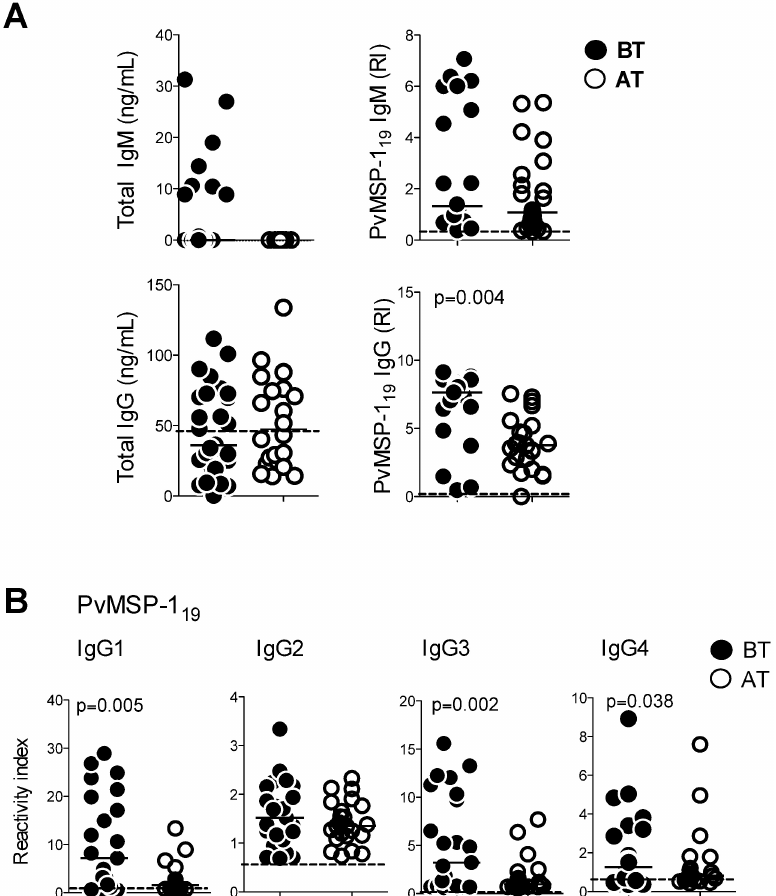
Fig 4. Increasein the reactivity index of IgM and IgG against MSP-1 19 from Plasmodium vivax during malaria. A. Total and Plasmodiumvivax -specific antibodieswere measuredby enzyme-linked immunosorbent assay (ELISA). Total and PvMSP-1 19 IgM and IgG were measuredin plasma of patients duringacute malaria (BT) and after treatment (AT). B. IgG subclasses againstPvMSP-1 19 were measure in plasma of patients duringacute malaria(BT) and after treatment (AT). Lines represent medianvalues of the given measurement in each group. Dotted lines represent healthydonors. p values are depictedin the figure.